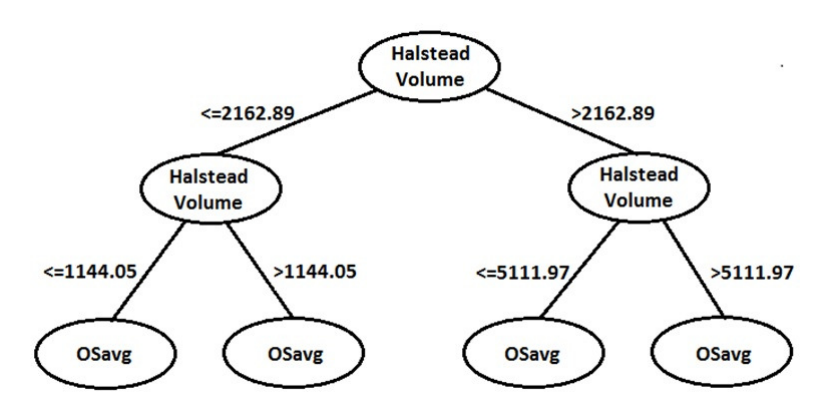
Figure 3. First three levels of the model for case study